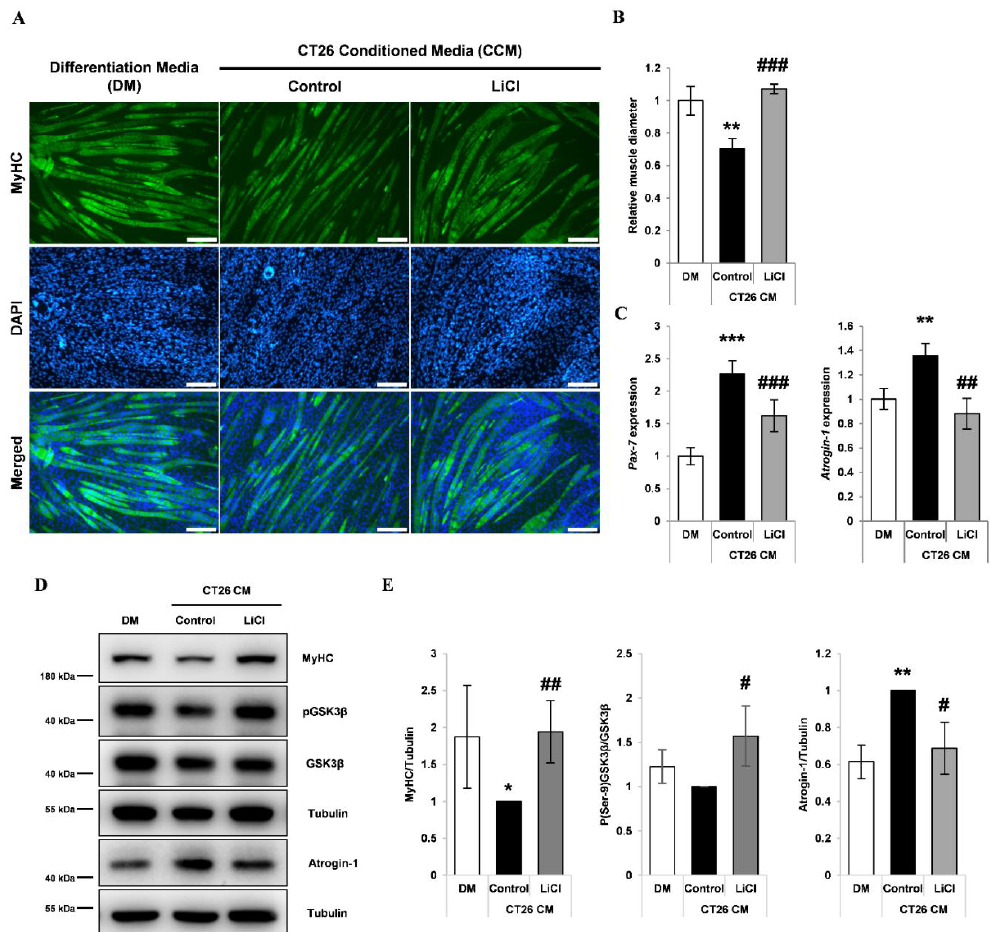
Figure 3. LiCl prevents CT26 colon carcinoma cell-conditioned media (CCM)-mediated wasting in C2C12 myotubes. ( A ) Immunofluorescence staining for MyHC after 72 h of culture in (1) differentiation media (DM), (2) CCM, and (3) CCM and 5 mM LiCl. DAPI staining was used to visualize cell nuclei. Scale bar = 100 µ m (n = 4). ( B ) Quantification of relative myotube diameter (n = 4). ( C ) qPCR of Pax-7 and Atrogin-1 expression in myotubes cultured with (1) DM at the start